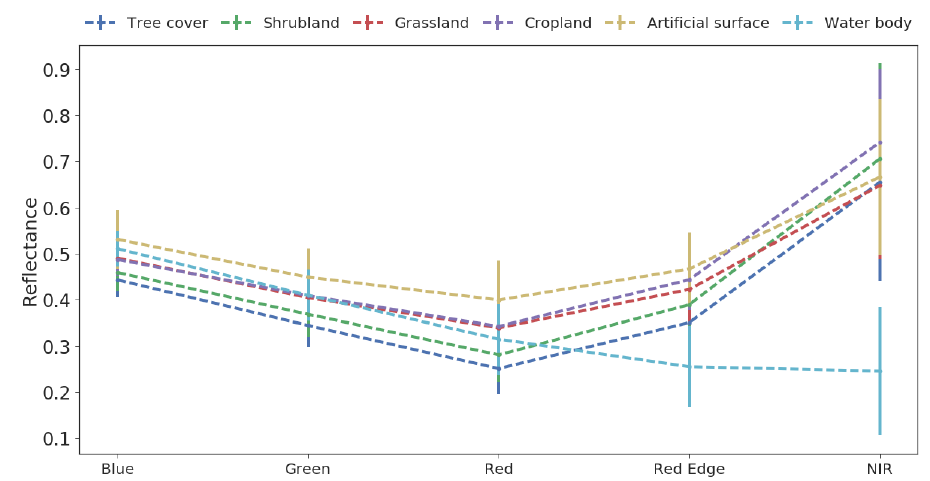
Figure 14. The spectral information of all